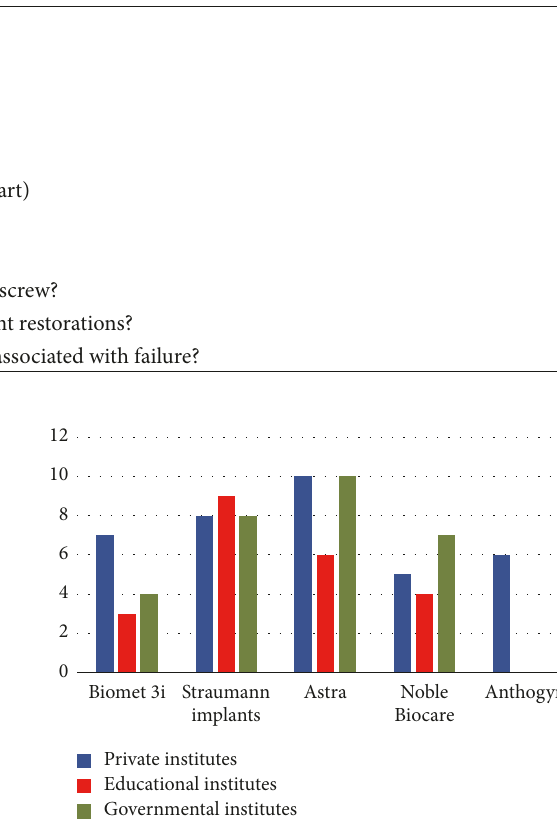
Figure 2: Implant manufacturers products: Biomet 3i, Inc. (Palm Beach Gardens, Florida); Astra Tech, Inc. (Waltham, Mass); Nobel Biocare AB (G¨oteborg, Sweden); Straumann USA, LLC (Andover, MA); and Anthogyr (Sallanches,